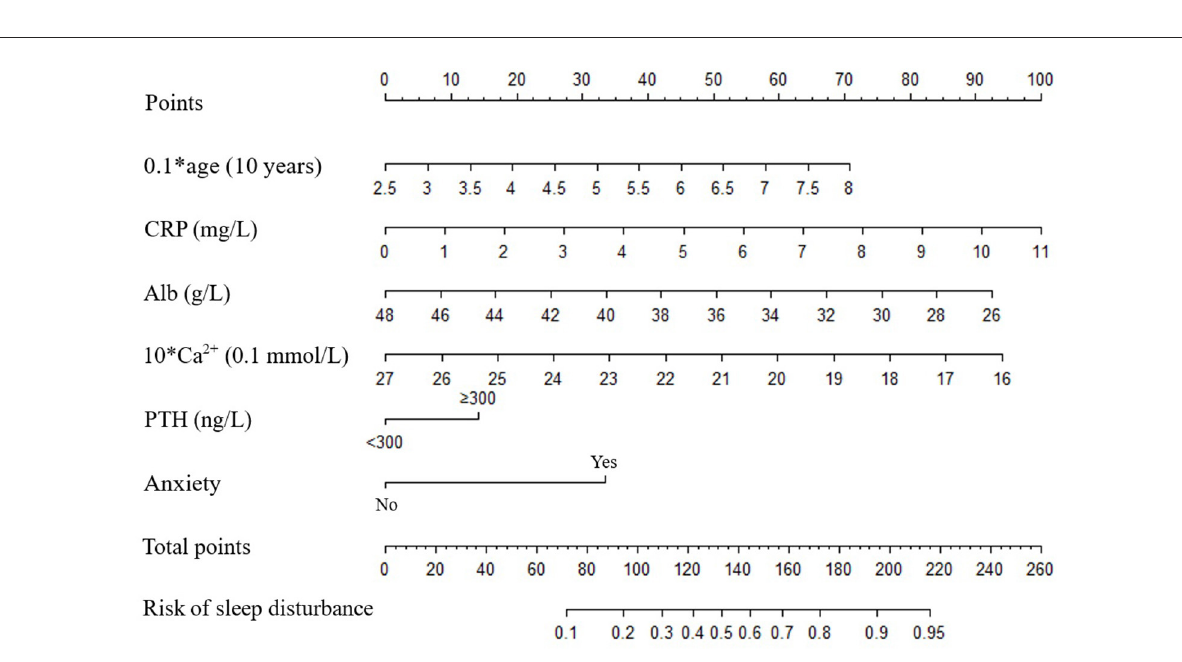
FIGURE2 Nomograms predict the risk of sleep disturbance in patients with MHD. Alb, albumin; Ca 2 + , calcium; CRP, C-reactive protein; PTH, parathyroid